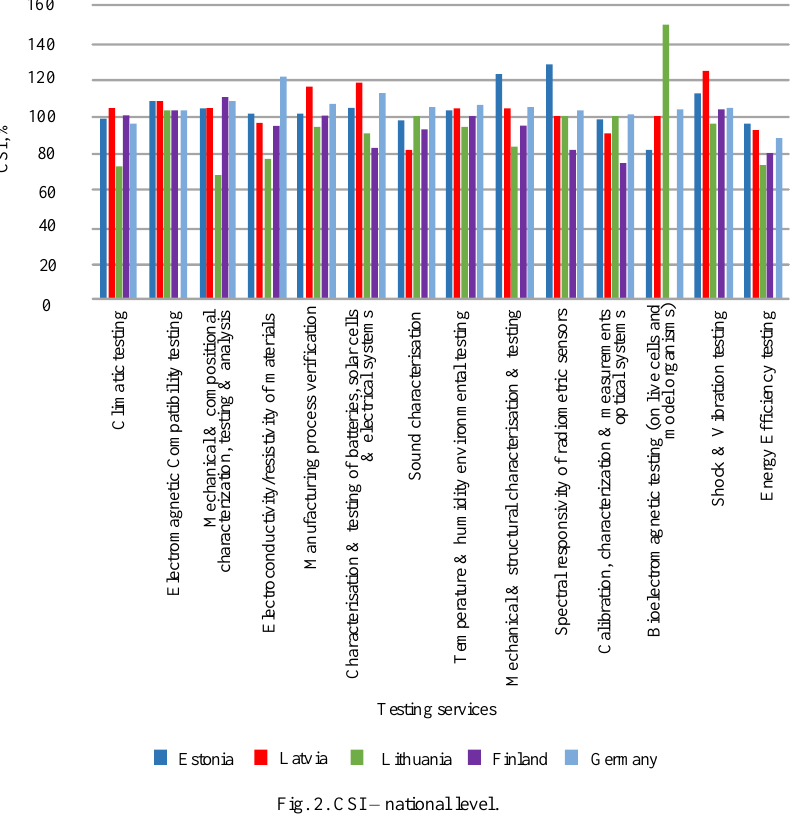
Fig. 2. CSI – national